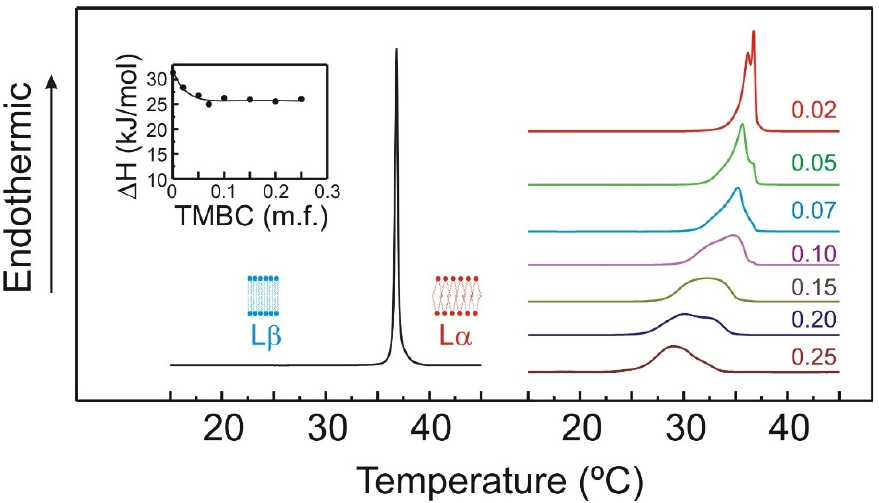
Figure 2. DSC heating thermograms for pure DMPS ( left ) and DMPS containing TMBC at different concentrations ( right ). The inset shows the enthalpy change for the main gel to liquid ‐ crystalline phase transition. TMBC molar fractions are expressed on the right side of the thermograms.